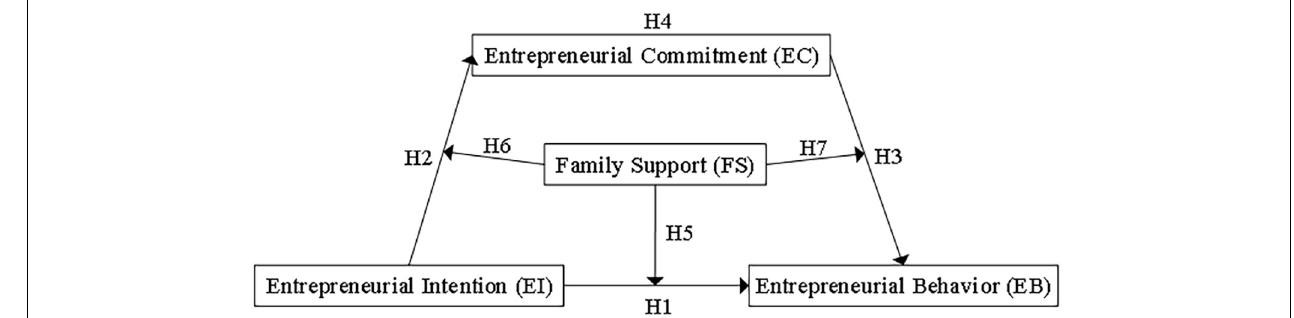
FIGURE 1 | Conceptual model.